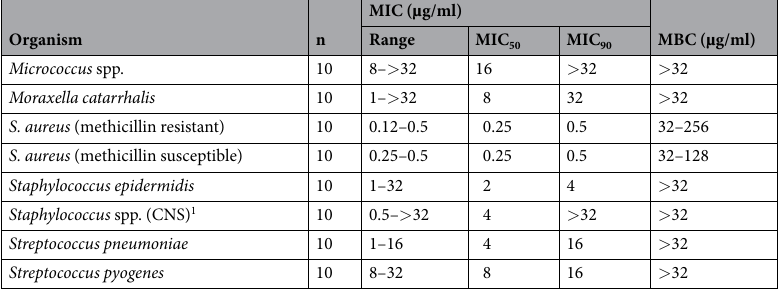
Table 1. Minimum inhibitory and bactericidal concentrations of 135C . 1 CNS, coagulase-negative = Staphylococcus